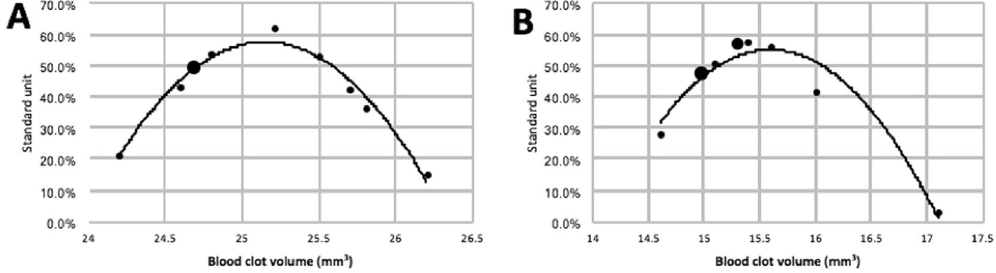
Figure 2. Normal distribution of repeated measures for stenosis ( A ) and for full occlusion ( B ). The small dot represents one measure. The larger dot represents two measures (giving the same value).